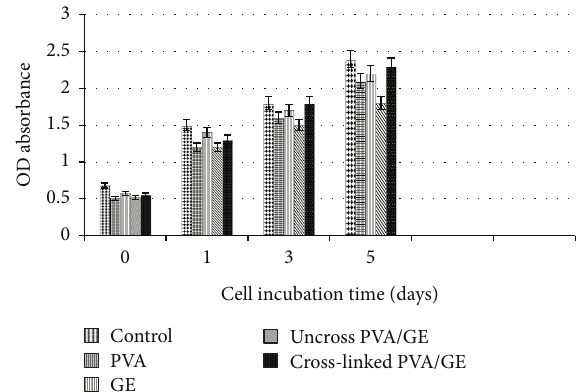
Figure 3: Fibroblast cellular proliferation of PVA, GE, uncross PVA/GE, and cross-linked IPN PVA/GE blend after 3 cycles and 1, 3, and 5 days using the MTT assay. Standard errors were expressed in the bar diagram. Media at 100% were used as a control and optical density (OD) corresponded to the cell survivability after 1, 3, and 5